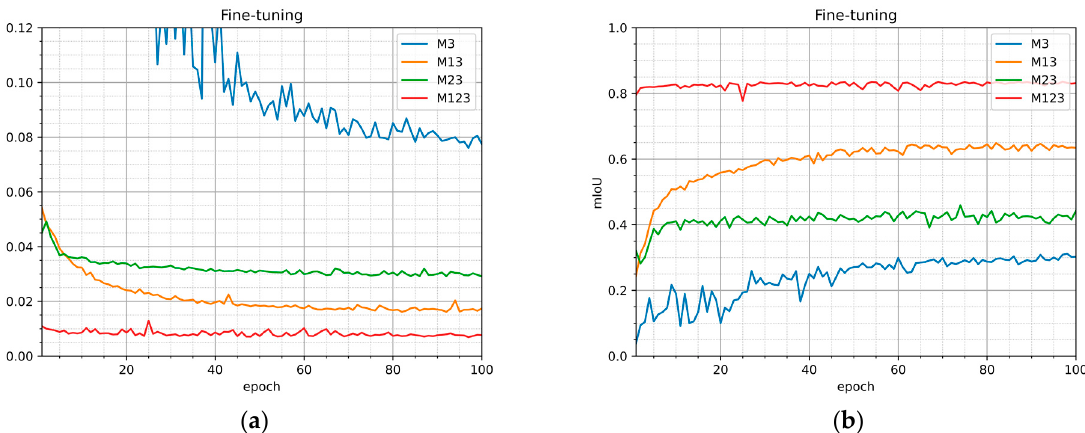
Figure 7. Evaluation metrics (focal loss ( a ) and mIoU ( b )) for fine ‐ tuning validation set during the fine ‐ tune training of the models M3, M23, M13, M123.